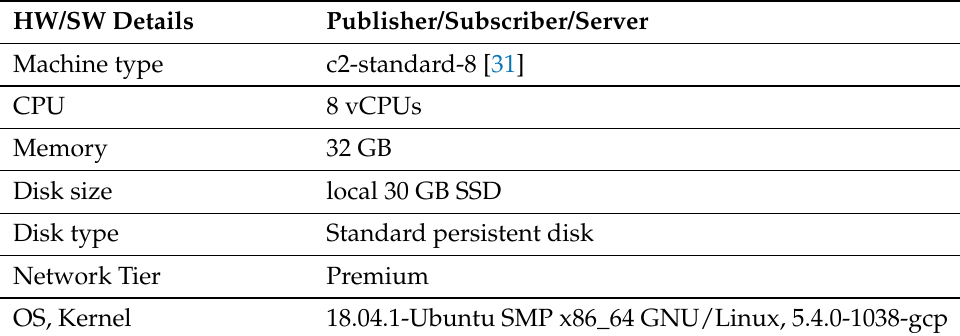
Table 3. Hardware and software details of the cloud testing